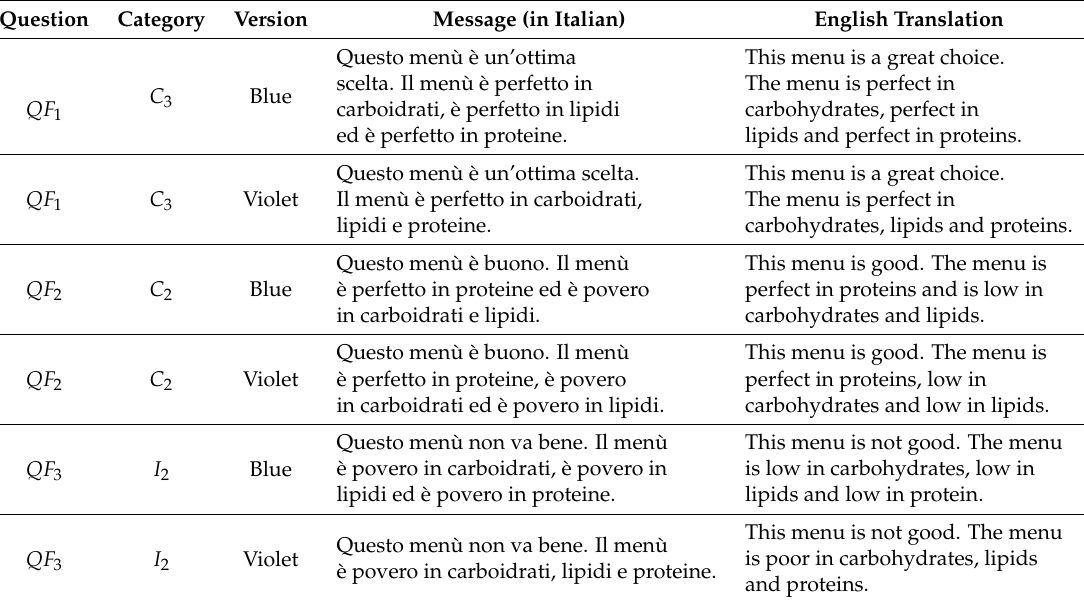
Table A1. The messages used in Experiment